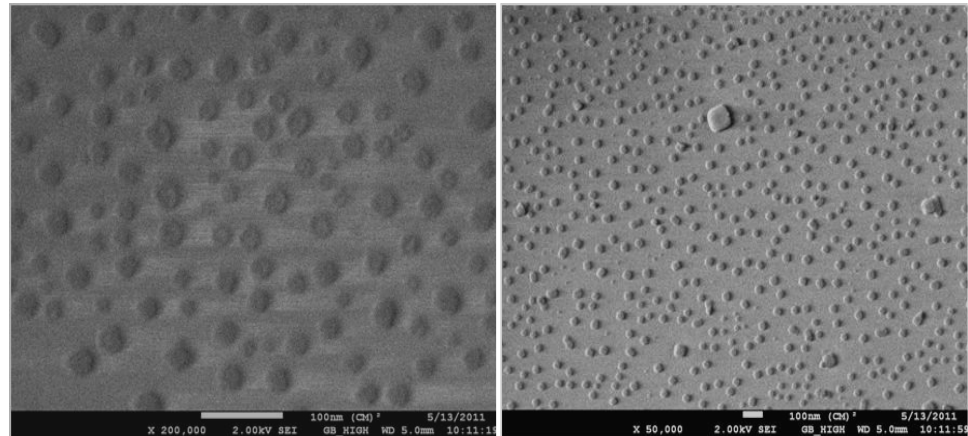
Figure 6. SEM image of the MW-irradiated sample (the image at left is an enlarged